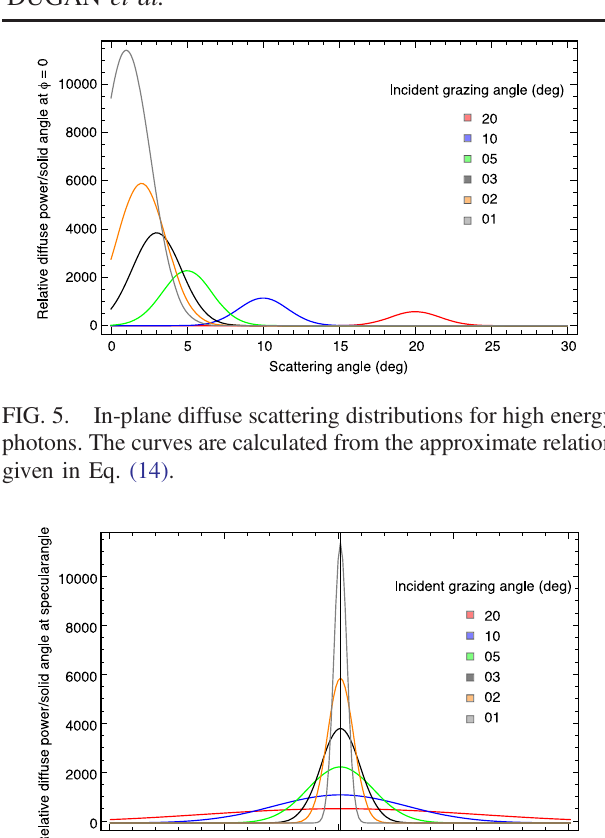
FIG. 6. Out-of-plane diffuse scattering reflected angle distri- butions for high energy photons. The curves are calculated from the approximate relation given in Eq. (14).